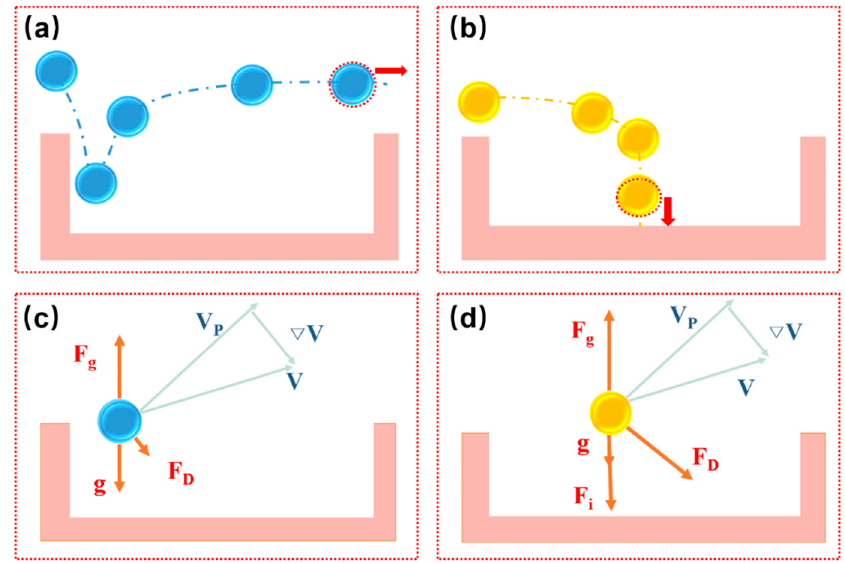
Figure 7. Schematic of particles flowing through the microwell. ( a ) Particle flowing through the microwell. ( b ) Particle captured by the microwell. ( c , d ) Diagrams of the forces acting on a particle.